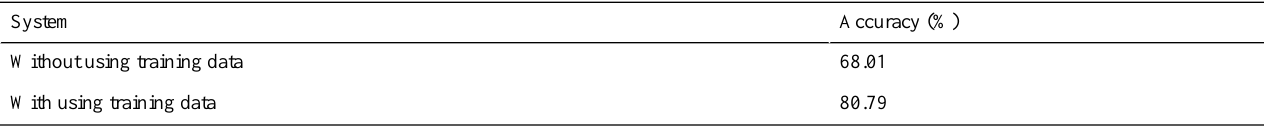
Table 5. Results obtained with and without using the training data.